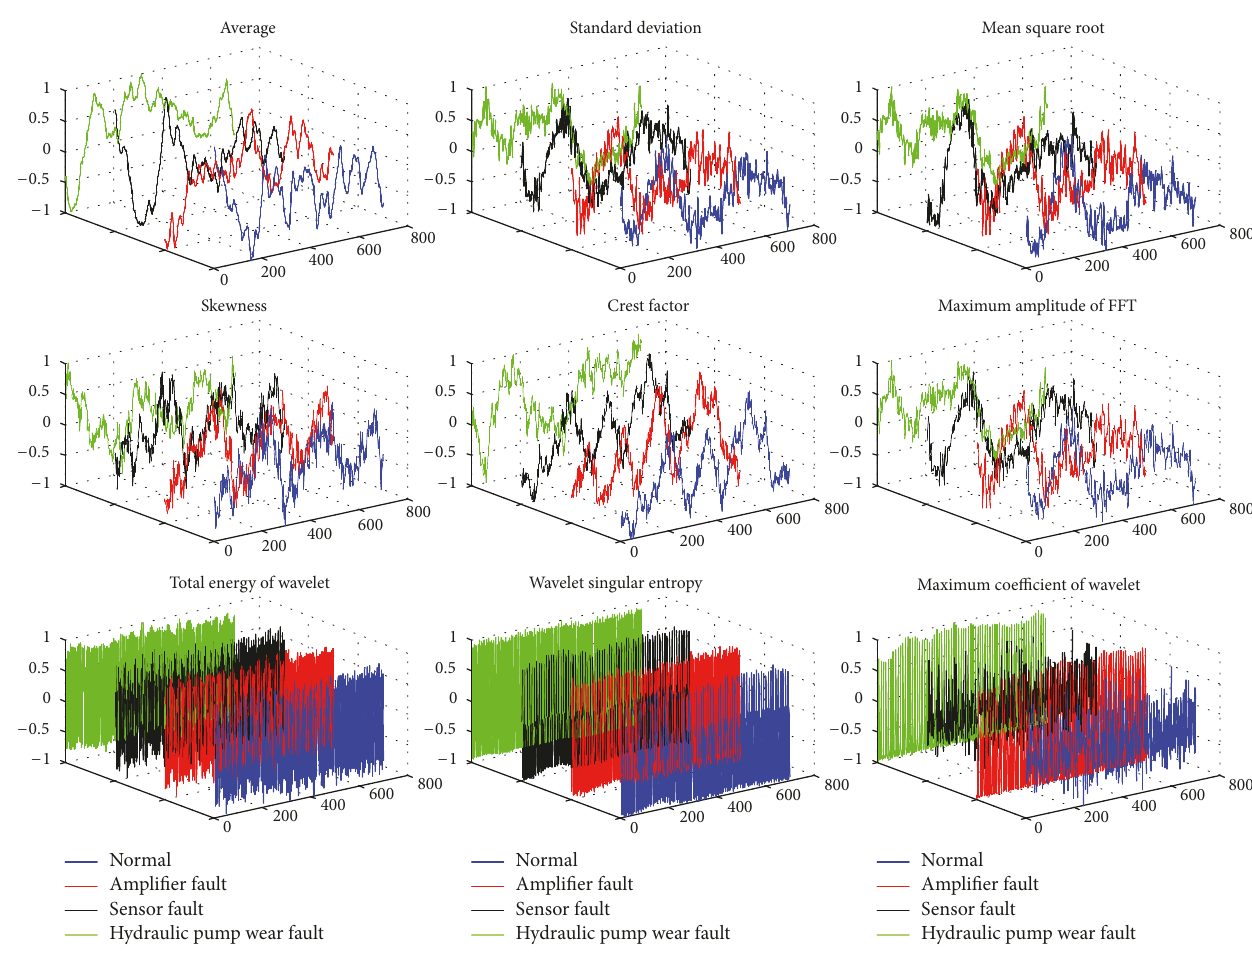
Figure 5: Feature vectors of the hydraulic servo system in different states. Table 2: Extracted features of the output signals of hydraulic servo system.